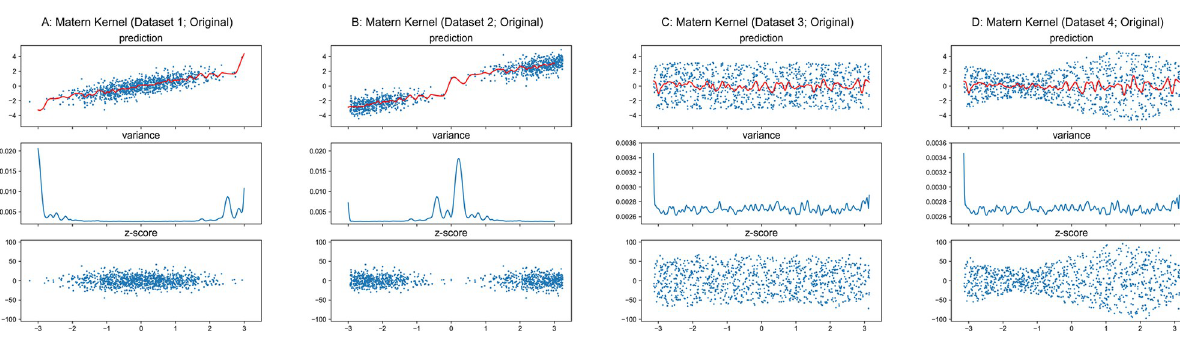
Fig 8. GPR with mate´rn kernel on original datasets. Scales of Y-axis for variance plots are different.